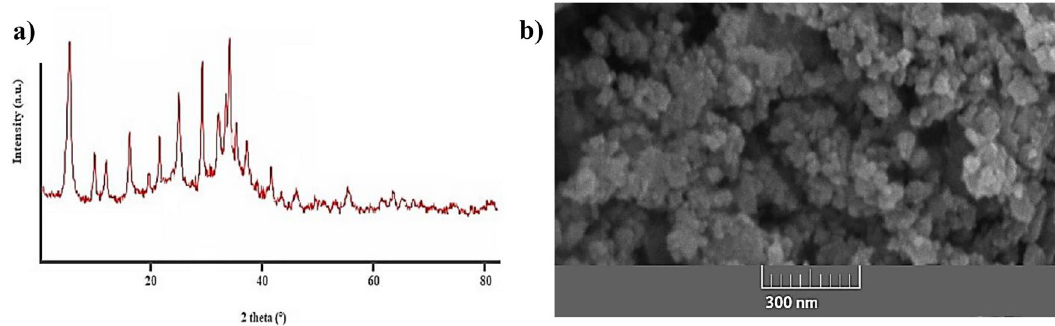
Figure 2. (a) XRD pattern of nanozeolite-X, (b) SEM image of the corresponding sample.